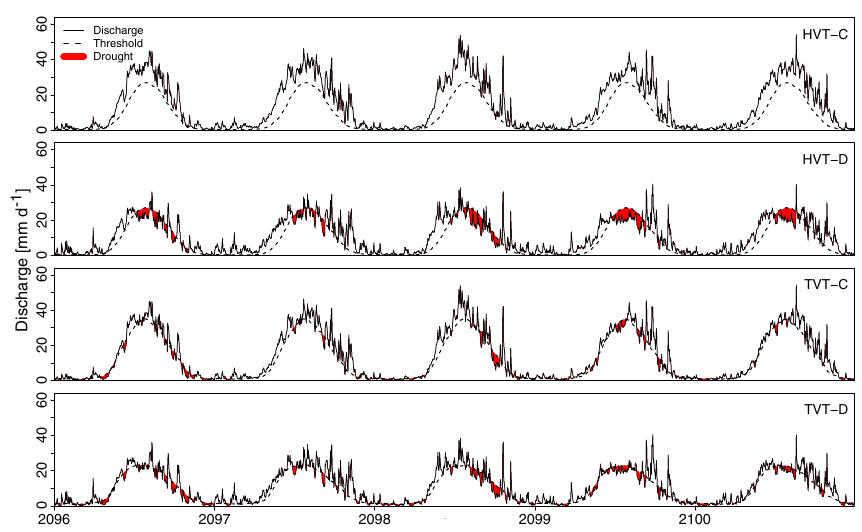
Figure 8. Example time series of possible timing and deficit volume of droughts in the four scenarios (HVT-C, HVT-D, TVT-C and TVT-D). The droughts are shown for the Nigardsbreen catchment and the RCP4.5 climate scenario for the period